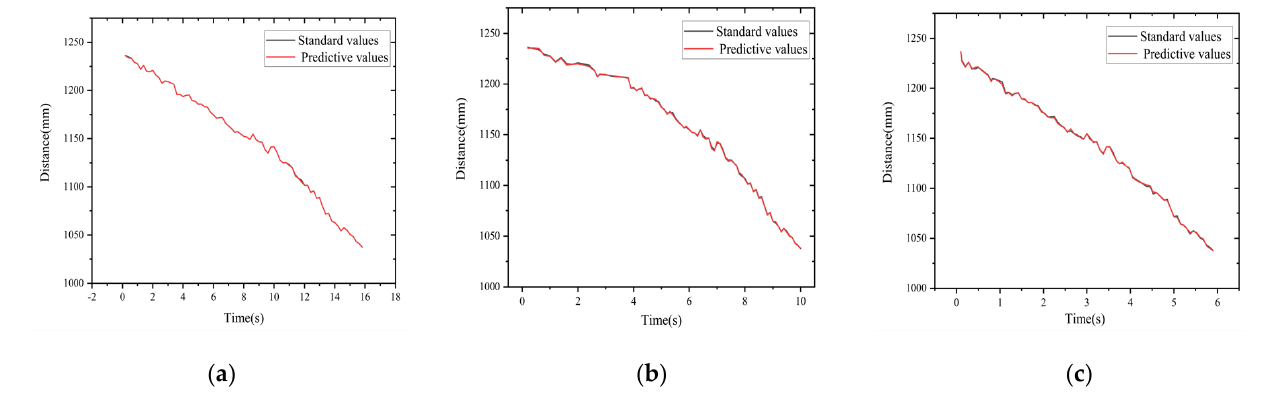
Figure 17. Depth − standard value vs. predicted value. ( a ) 20 mm/s. ( b ) 40 mm/s. ( c ) 60 Figure 17. Depth− standard value vs. predicted value. ( a ) 20 mm/s. ( b ) 40 mm/s. ( c ) 60 mm/s.